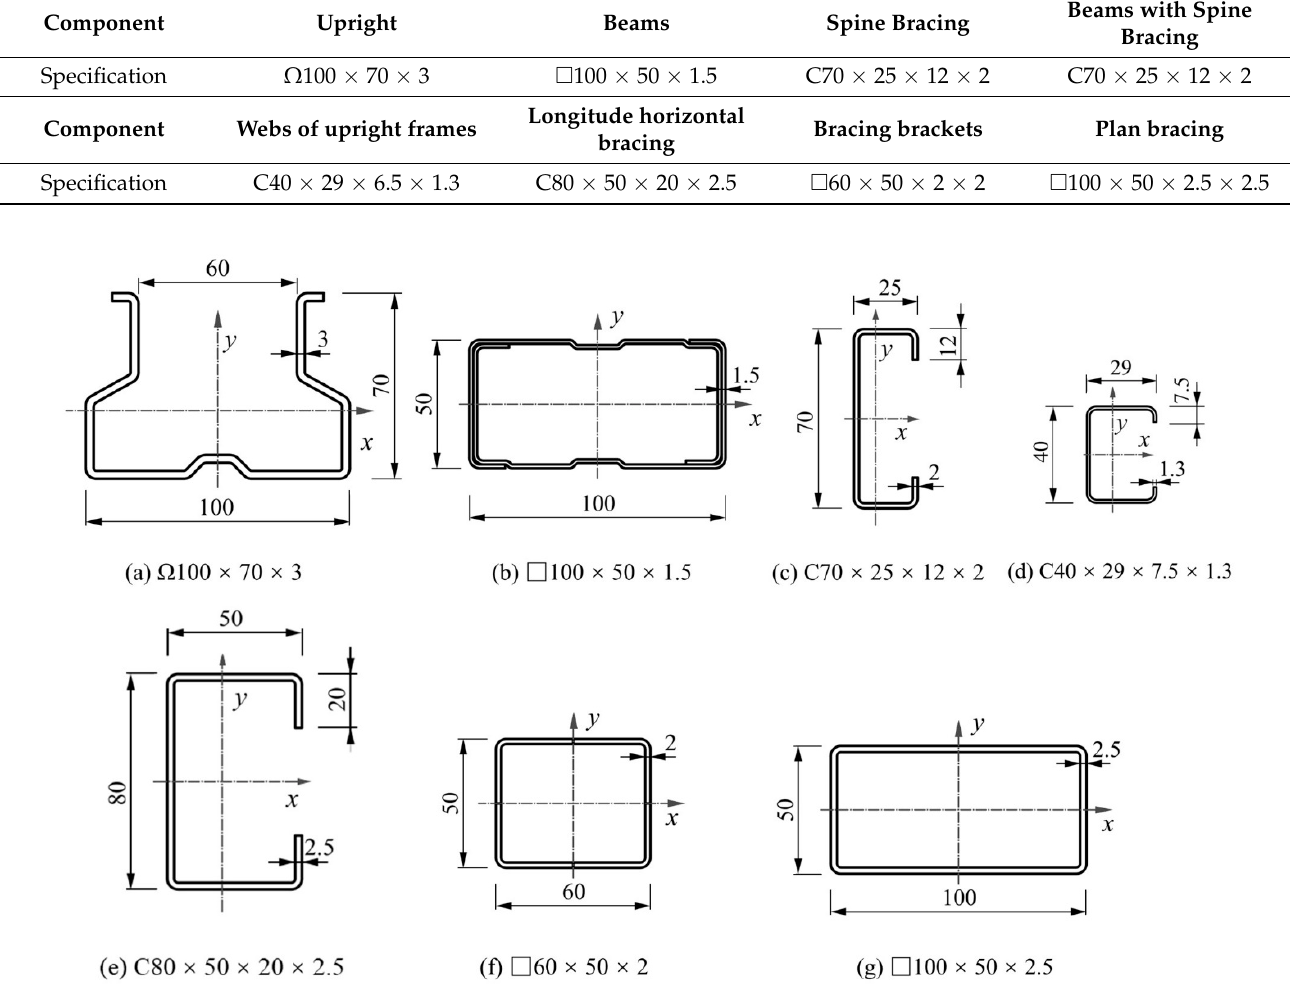
Figure 1. Detailed dimensions of the components. Table 1. Model component specifications.